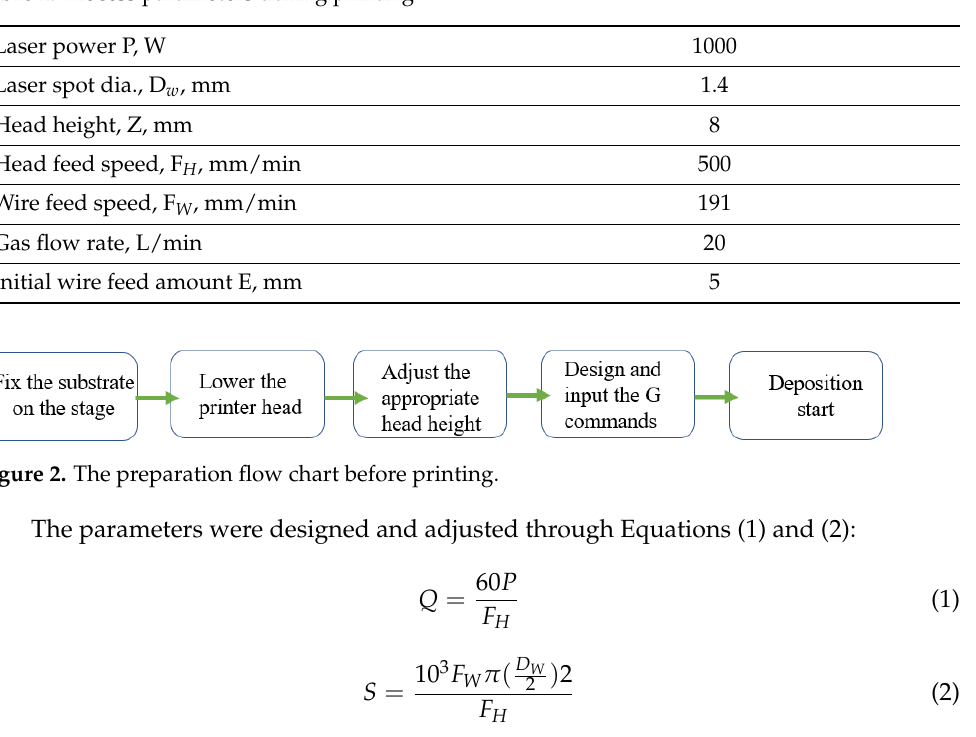
Table 2. Process parameters during printing.